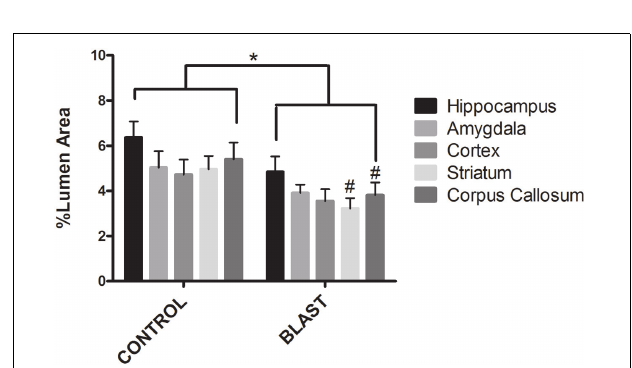
FIGURE 3 | Blast exposure significantly reduced glycocalyx thickness in rats. Mean area of the glycocalyx quantified for each brain region and expressed as a percentage of the total capillary lumen area. Capillaries from blast exposed rats showed a significant reduction in glycocalyx area in the Corpus Callosum (3.811%), Striatum (3.217%), and Hippocampus (4.849%) compared to sham controls (5.403, 4.958, and 6.371%, respectively) Asterisk denotes global significance between sham blast and blast exposed capillaries (5.297% vs. 3.867%, Two way ANOVA, p = 0.0003); while pound symbol